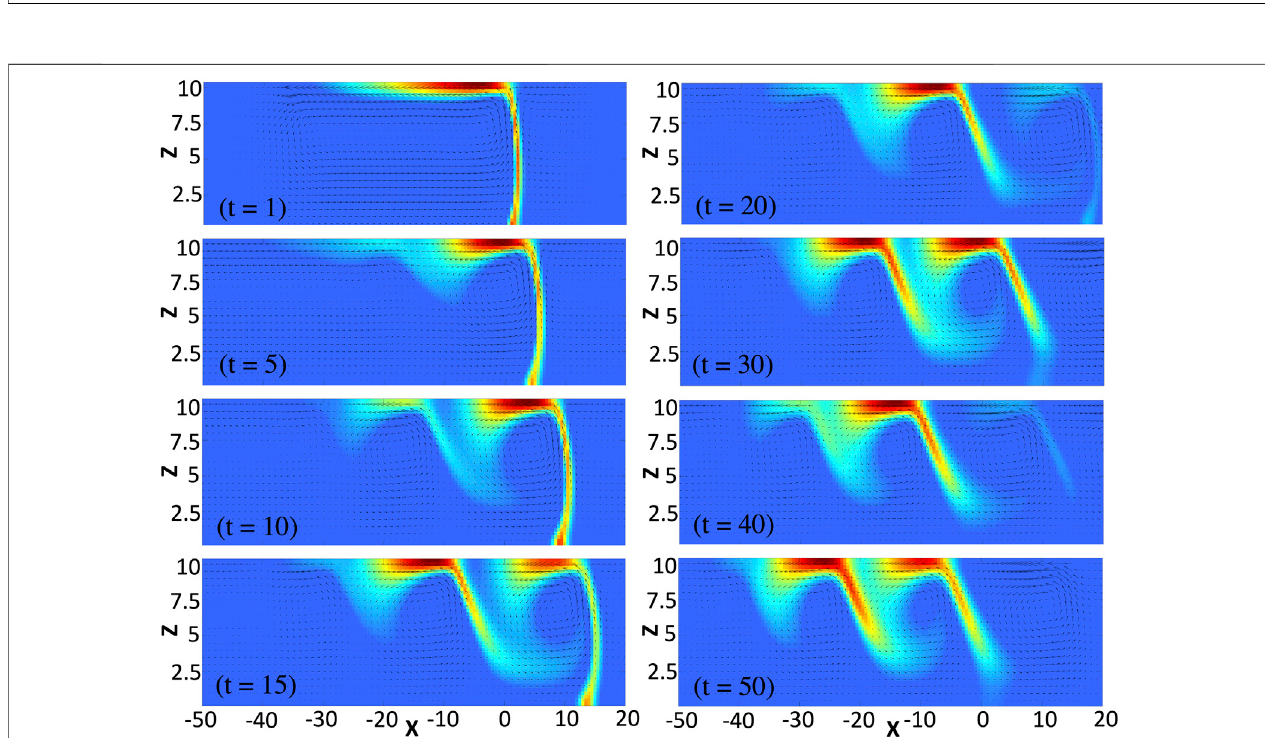
FIGURE 2 | Spatial oscillations of surface tension pro fi les at different times for M a = 250 = M b , M c = 500, β = 2, δ b = 0.25, δ c = 0.50 and L z = 10. Such pro fi les are separated in two plots, (A,B) , for clarity.